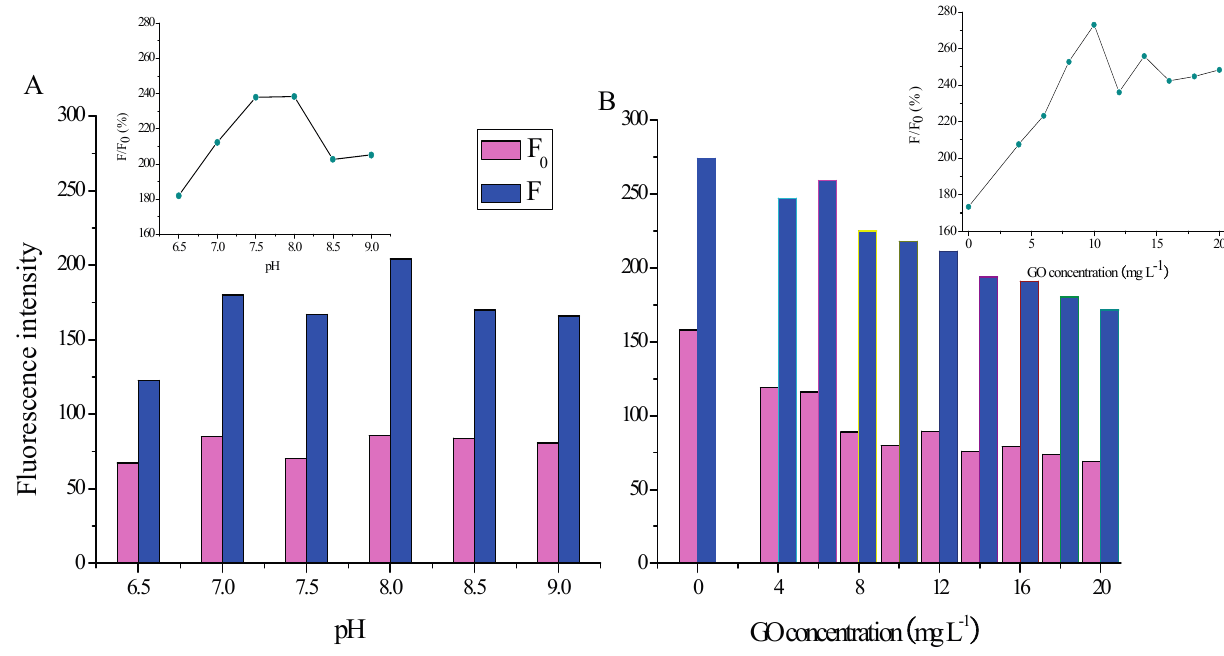
Figure 4. Fluorescence intensity of the GO/probe 2/quinaldine red platform. ( A ) in pH from 6.5 to 9.0 respectively in the absence of T-DNA ( F 0 , colored magenta) or presence of T-DNA ( F , colored blue). Inset: F / F 0 in pH from 6.5 to 9.0; ( B ) in GO from 0 to 20 mg·L − 1 respectively in the absence of T-DNA ( F 0 , colored magenta) or presence of T-DNA ( F , colored blue). Inset: F / F 0 in GO from 0 to 20 mg·L − 1